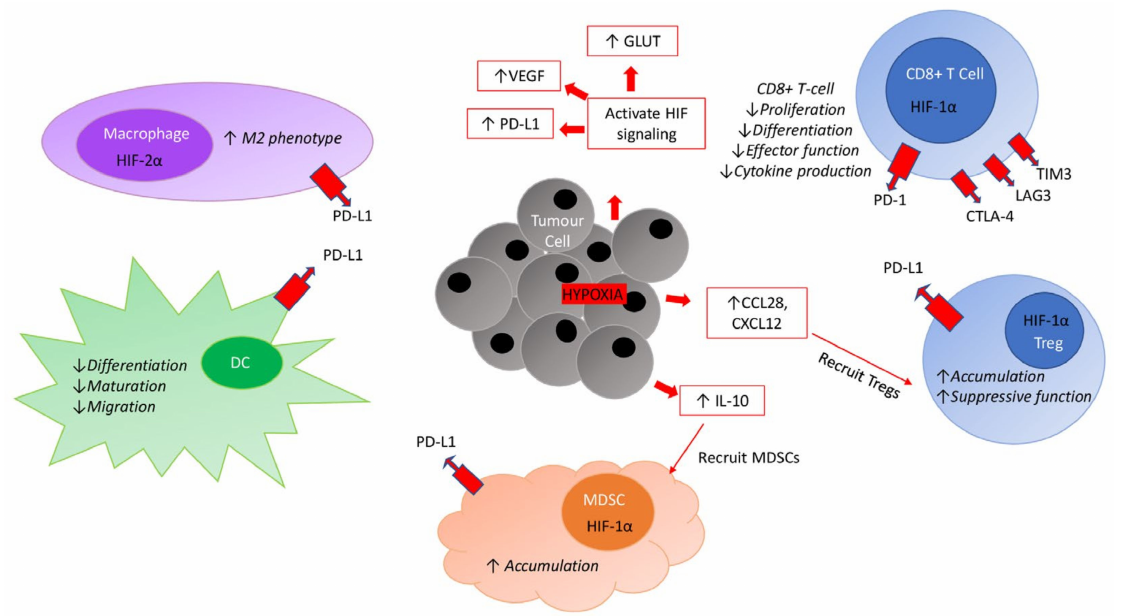
Figure 2. Hypoxia-driven immune escape within the tumour microenvironment (TME). The hypoxic environment promotes tumour production of interleukin (IL)-10 to recruit myeloid-derived suppressor cells (MDSCs) and regulatory T-cells (Tregs) to the TME. Hypoxia-induced expression of CC-chemokine ligand 28 (CCL28) and CXCL12 recruits Tregs to the TME. Hypoxia inducible factors (HIF)-1 α and -2 α transcriptionally upregulate vascular endothelial growth factors (VEGFs) to promote proangiogenic signalling in addition to recruiting Tregs to the TME. The HIF pathway also increases glucose transporters (GLUTs) to support substrate provision for tumour glycolysis. Upregulation of PD-L1 on tumour cells is HIF-1 α -dependent. Impaired maturation and reduced production of cytokines such as interferon (IFN)- γ in dendritic cells (DCs) occurs in hypoxic environments. Upregulation of inhibitor programmed cell death ligand 1 (PD-L1) on DCs, Tregs, macrophages and MDSCs are all dependent on HIF signalling. TME Hypoxia regulates the expression of inhibitory checkpoint proteins. Cytotoxic T-lymphocyte antigen-4 (CTLA-4), lymphocyte activating 3 (LAG3), T-cell immunoglobulin domain and mucin domain 3 (TIM3) and PD-1 are up-regulated on CD8+ T-cells in a HIF-1 α -dependent